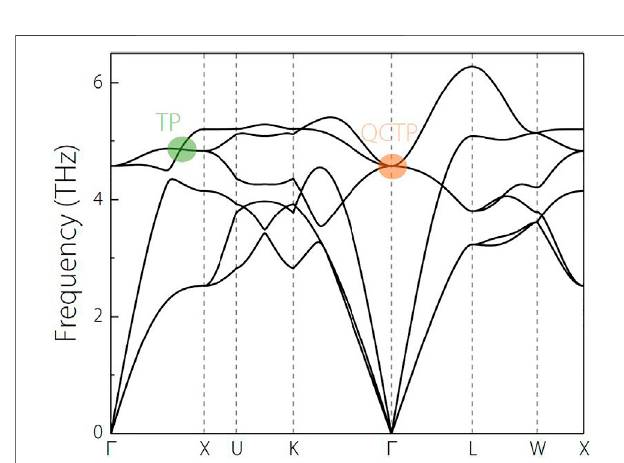
FIGURE 3 | Phonon dispersion of NaCl along the Γ -X-U-K- Γ -L-W-X